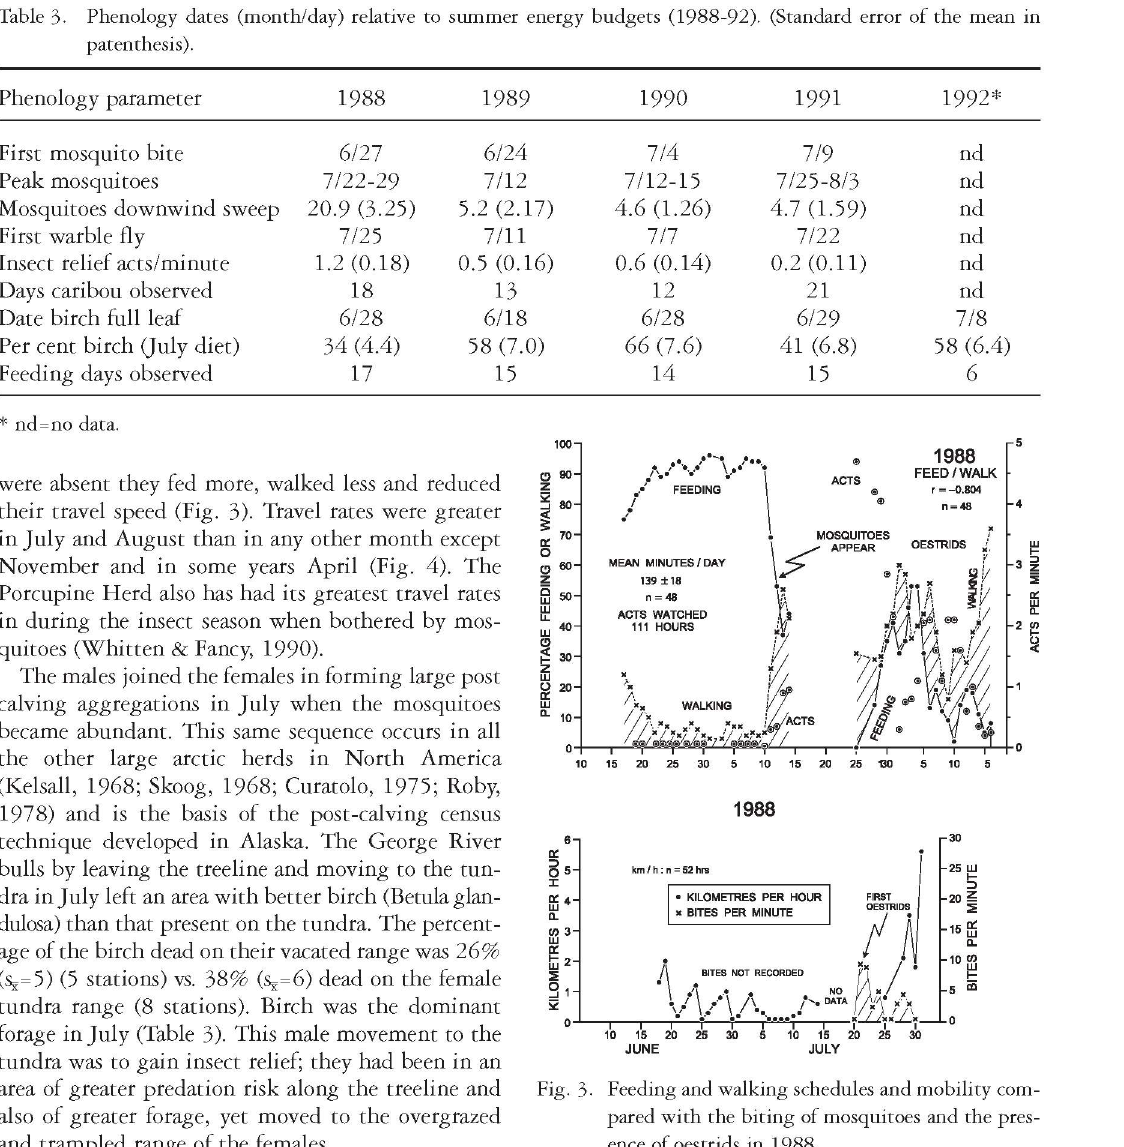
Fig. 3. Feeding and walking schedules and mobility com¬ pared with the biting of mosquitoes and the pres¬ ence of oestrids in